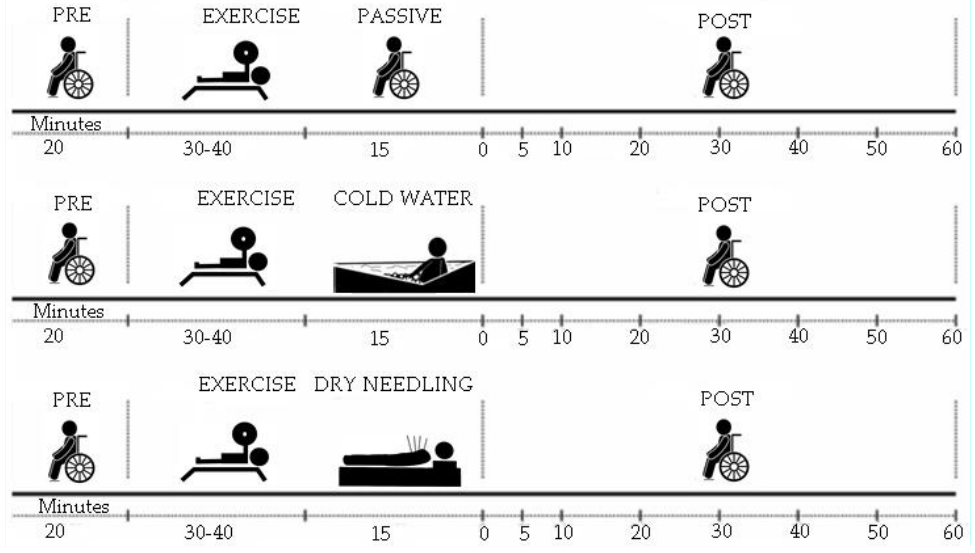
Figure 1. Experimental design.